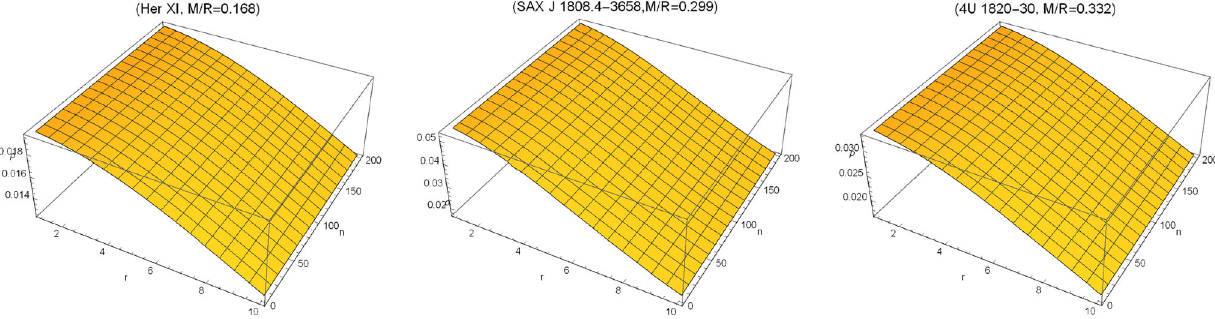
Fig. 3 Behavior of energy density ρ with radial coordinate r (km) and model parameter n